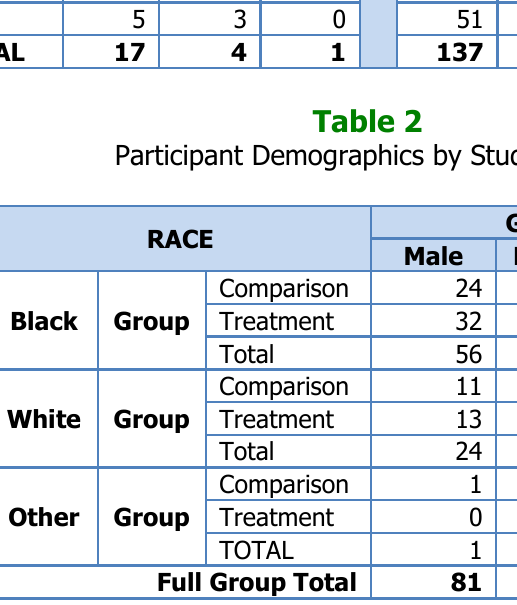
Participant Demographics (Gender and Race by Grade) 5 th Grade (n = 22) GENDER